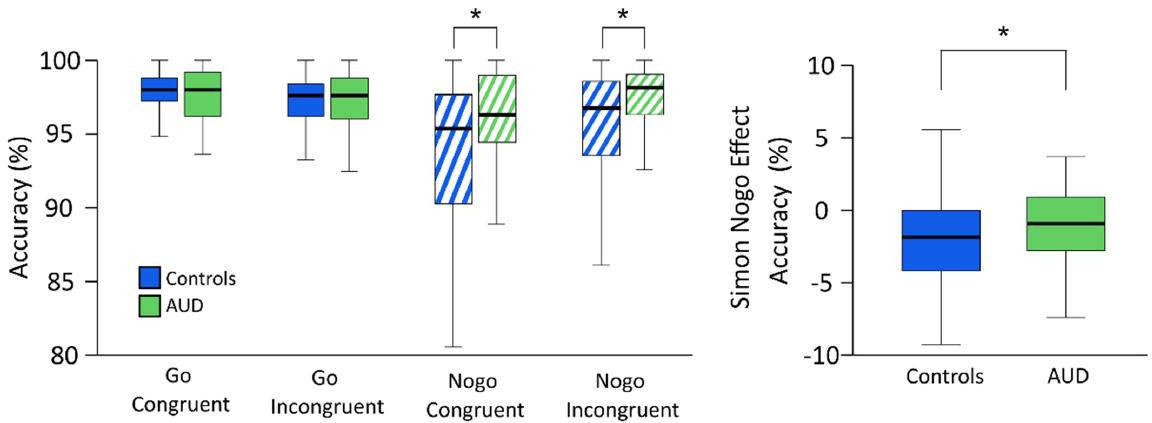
Figure 2. Behavioral results. The box plots illustrate the mean accuracy in percent (%) for the four